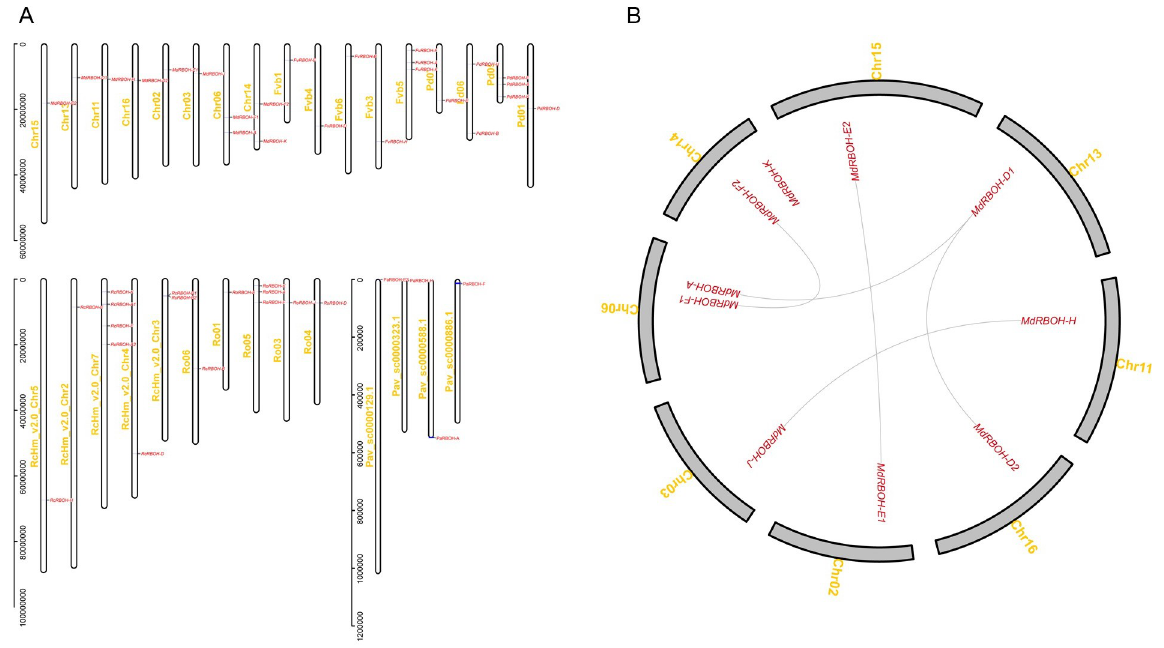
Fig 2. Chromosomal distribution and duplication of RBOH genes. (A) Chromosomal distribution of the RBOH genes among six Rosaceae species. (B) Synteny analysis of the apple RBOH genes. Syntenic apple RBOH genes are linked by lines.